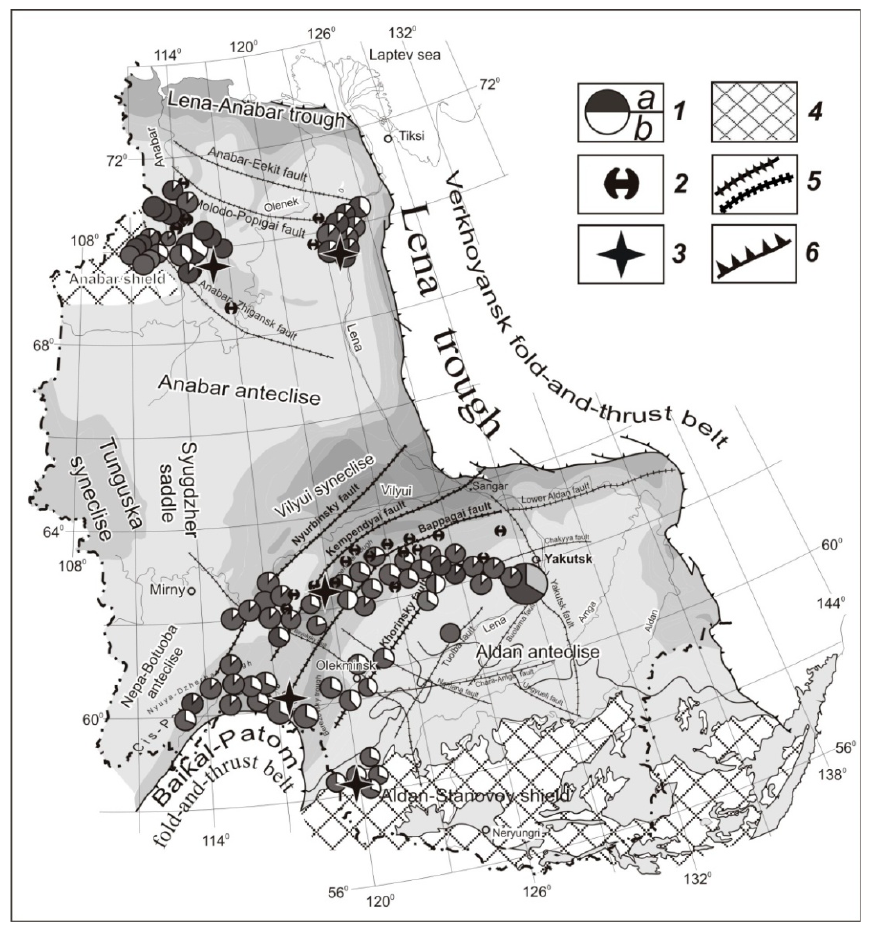
Figure 1. Diagram of the studied area and area of distribution of aeolian and two types of gold in the East Siberian platform: 1—types of gold and their ratio (%): а —I type: size 0.10–0.25 mm, fineness >900‰, b—II type: size >0.25 mm, fineness 600–800‰; 2—aeolian gold; 3—places